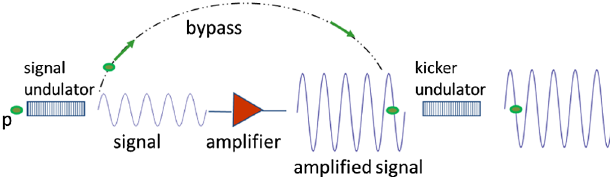
FIG. 1. A cooling system of a transient-time method of optical stochastic cooling